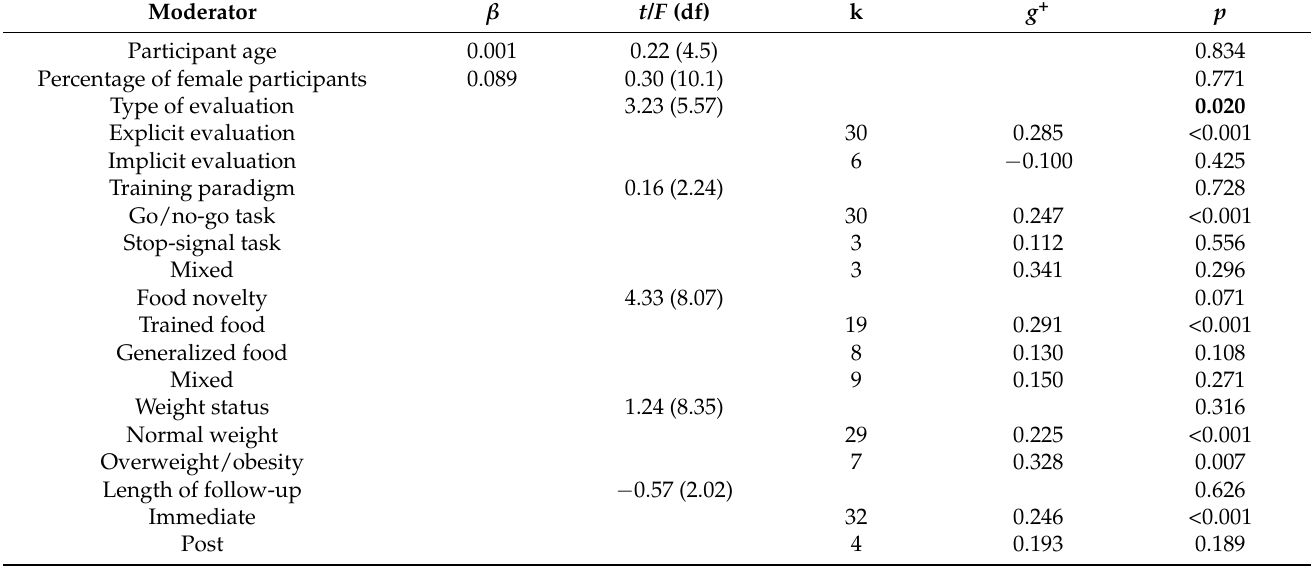
Table 2. Moderator analysis of the effects of food-specific inhibition training on food